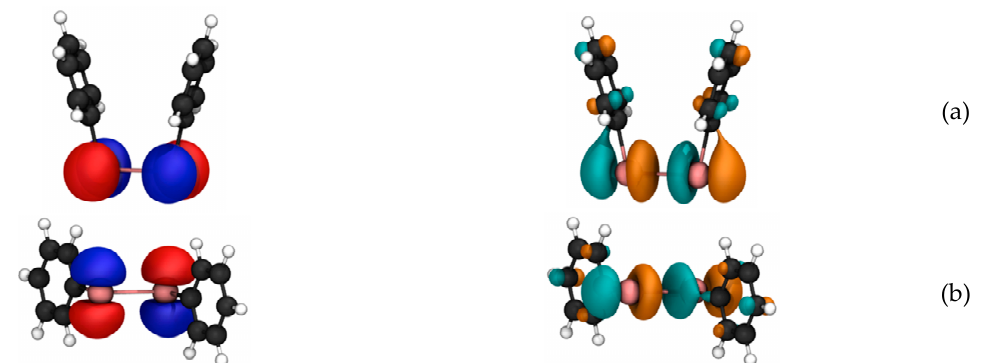
Molecules 2019 , 24 , x 11 of 18 Figure 7. LUMO of Ph 2 Te 2 : relaxed geometry ( left ) and geometry with the maximum imposed Te–Te bond deformation ( right ). Isodensity 0.05 a.u. Level of theory: ZORA-OPBE/QZ4Pae//ZORA- OPBE/TZ2P. Finally, we investigated the effects of a rotation around the Te-Te bond on the 125 Te shielding constant. Results showed a decrease of σ ( 125 Te) from an initial value of 2169.3 ppm ( Ψ = 0°) to a relative minimum of 2061.7 ppm recorded at Ψ = 76°, followed by an increase up to 2190.8 ppm (Figure 6B). Right after the minimum point, a non-monotonous increase can be observed, which is caused by the slightly different values of Φ 1 and Φ 2 at each point during the completely relaxed torsional scan. Nevertheless, the profile of σ ( 125 Te) follows the trend of the Te–Te distance, since when the chalcogen atoms get closer or further, the shielding constant decreases or increases, respectively (Figure 6B). This behavior follows from Schreckenbach analysis since the elongation of the inter- chalcogen bond leads to a stabilization of the LUMO and thus to a larger (negative) σ p and consequently to a higher 125 Te chemical shift, as explained in the previous paragraph. The HOMO–LUMO pair provides a very small σ pocc-virt contribution in the structures with Ψ equal to 0° or 180° due to their shape (Figure 8) that results in almost no HOMO–LUMO overlap after application of the magnetic moment operator due to the cancellation of the positive and negative orbital phase. Conversely, the largest contributions to σ p arise from the HOMO-2–LUMO and HOMO-1–LUMO pairs when Ψ = 0° with values of − 716.8 and − 698.1 ppm respectively, and from the pair HOMO-1–LUMO when Ψ = 180°, with a value of − 801.7 ppm. Although the energy gap is larger than for HOMO–LUMO, the magnetic coupling is strong due to the composition of these orbital pairs in terms of Te p atomic orbitals. Comparing the two extreme structures obtained in the torsional scan with the fully optimized open conformer of Ph 2 Te 2 , it is clear how the intermediate value of Ψ found in the minimum energy structure, with the two phenyl rings arranged in skewed fashion, favors not only the strongest orbital interactions, but also enhances the magnetic couplings, resulting in the structure with the lowest isotropic shielding constant. These analyses have been carried out also with the inclusion of spin-orbit effects: the two limit structures, Ψ = 0° and Ψ = 180°, have been chosen because of the biggest difference between relativistic scalar and spin-orbit 125 Te shielding constants.